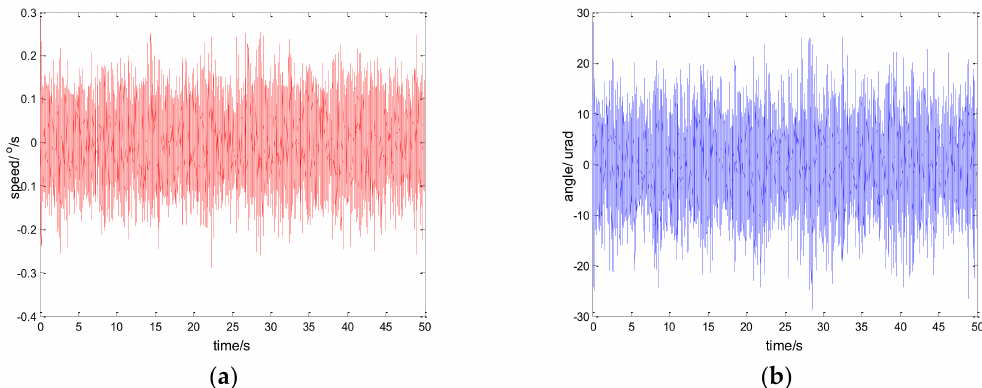
Figure 14. Experiment results of robust SMC with NTD. d = 3sin ( 2 π × 0.1 t ) : ( a ) speed; and ( b ) tracking error, RMS = 7.1381 urad.